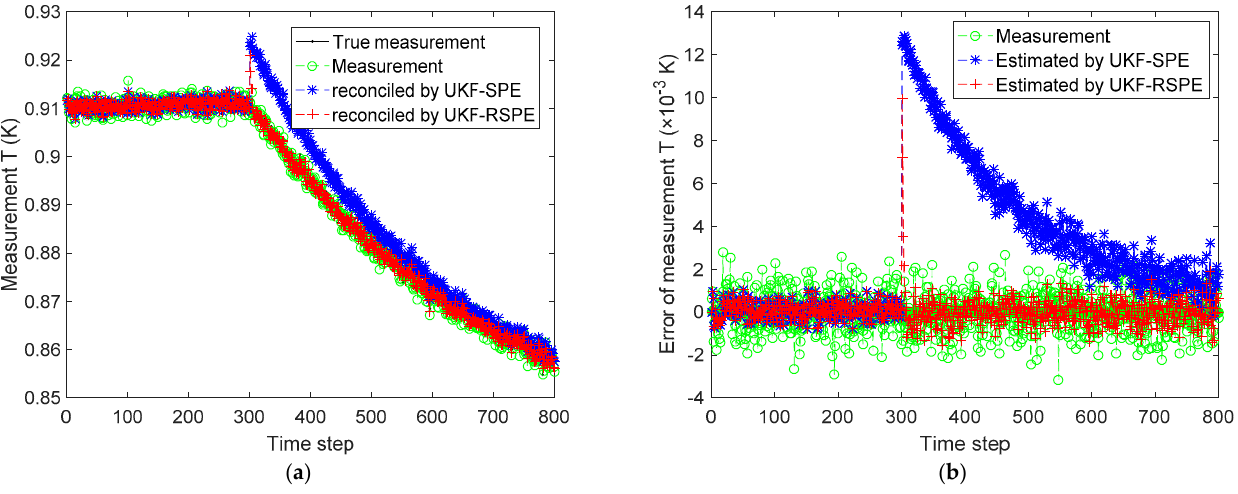
T  in Case Study 2.2: ( a ) rec- k